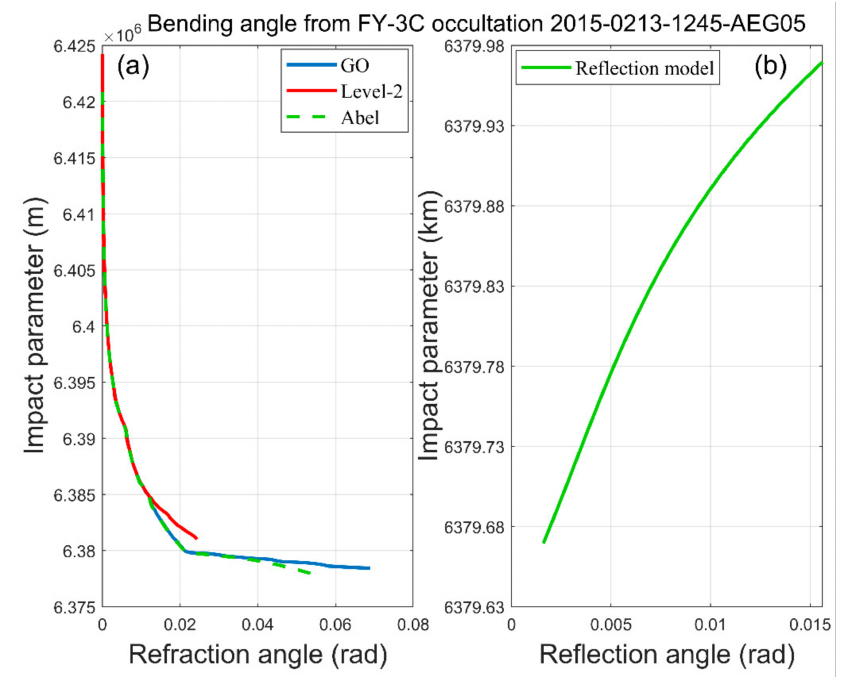
Figure 7. Bending angles of FY-3C event on 13 February 2015: in ( a ), the red curve shows the bending angles of refractivity profile from cutting height to 40 km altitude, the green dashed curve shows the bending angles by Equation (6) and the blue curve shows the recalculated bending angle by GO method from Earth’s surface to 40 km altitude; ( b ) shows the reflected bending angle model extracted by Equation (8).